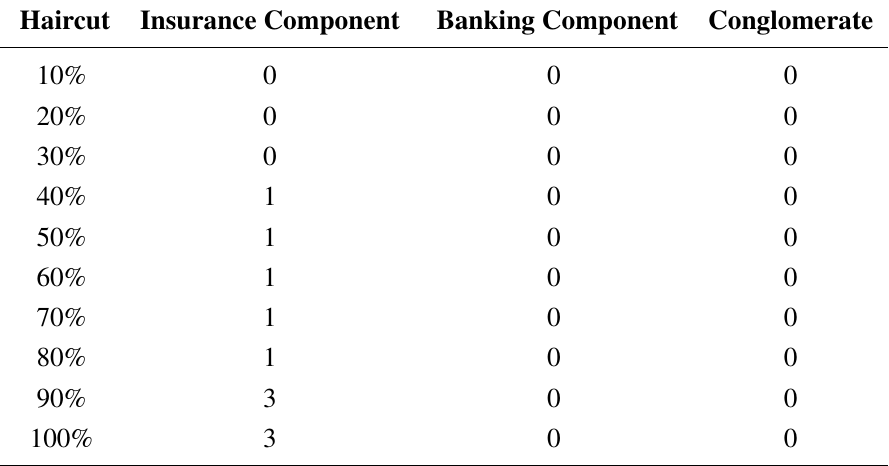
Table A1. Number of defaults for a shock on Italian sovereign debt: robustness check. When the Italian sovereign debt loses 40% of its value, one insurance component is in default, zero banking components are in default and zero conglomerates are in default.